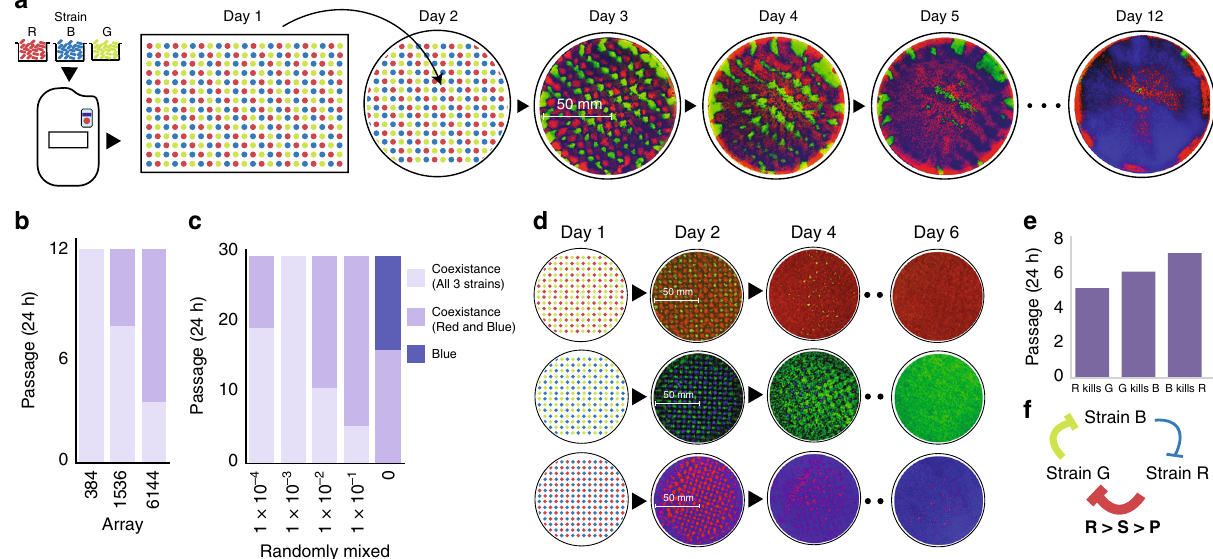
Fig. 2 Characterization of the ecology and causes of asymmetry. a Schematic diagram of the method used to create an ordered grid of RGB colonies on agar plate through the use of a liquid handling robot. On the right, images corresponds to passages of the lowest density grid (384). Passaging of plates was done by replica plating. This experiment was executed one time at this density and it was repeated at a higher density as shown in Supplementary Fig. 3. b Quanti fi cation of strain coexistence as a function of time for three different initial densities plated in grid format. c Quanti fi cation of strain coexistence as a function of time for fi ve different initial densities plated in a random distribution. d Paired competition on agar plates starting from an initial grid at 1536 density. e Quanti fi cation of time to takeover for each competing pair. f Diagram illustrating asymmetry in toxin strength in the RPS ecology. Strain R produces strong inhibition of Strain G, Strain G produces intermediate inhibition of Strain B, and Strain B produces weak inhibition of Strain R.